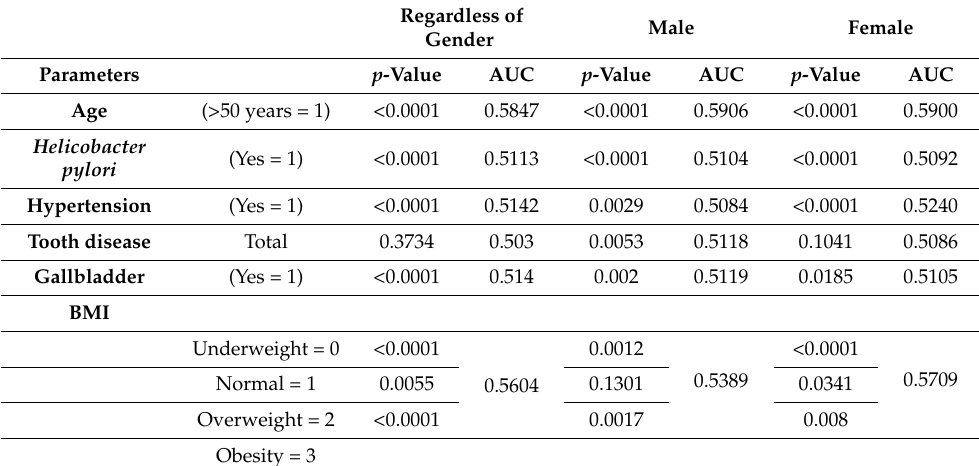
Table 2. Multinomial logistic regression analysis of variables for colorectal